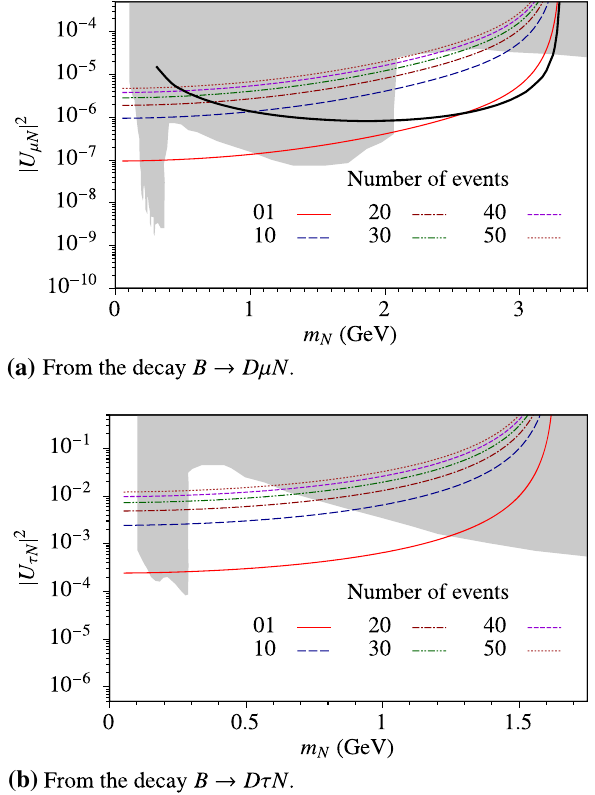
Fig. 1 Values of | U μ N | 2 and | U τ N | 2 estimated from observed number of events (less than 50 events) of the decays B → D μ N and B → D τ N , respectively, using the projected number of B decays at Belle II and assuming 0 . 1% chance of full reconstruction of τ from its decays. The B → D (cid:2) N decays include both the charged and neutral modes. The thick solid line corresponds to the predicted 95% C.L. upper-limit on | U μ N | 2 [36], for 4 . 8 × 10 12 B decay events at upgraded LHCb (with the decay B → D μμπ